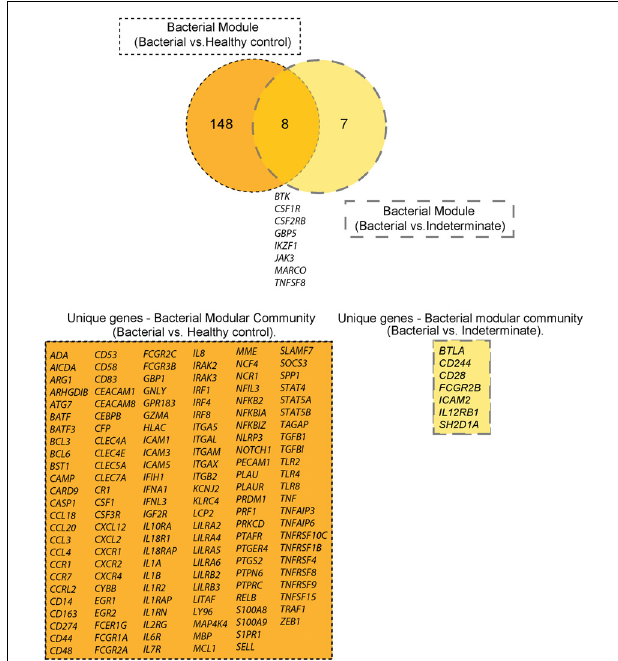
FIGURE 7 | Immune genes differentially expressed in nasopharyngeal aspirates of children with ARI. Venn diagram depicting the DEITs detected in NPAs displaying microbial load or NPAs classified as indeterminate. The intersection shows immune genes common to both categories.